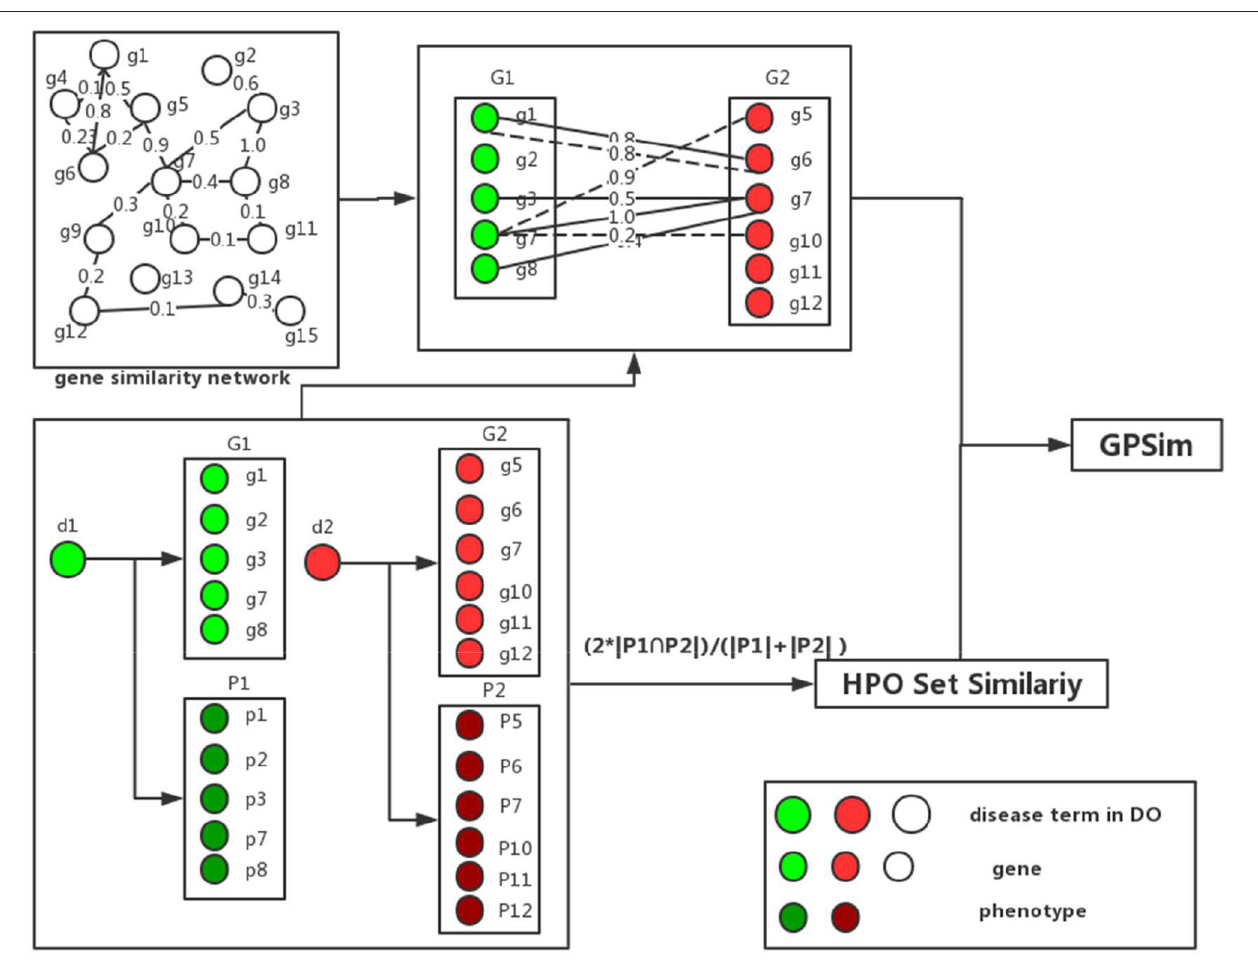
FIGURE 3 | The similarity calculation by using